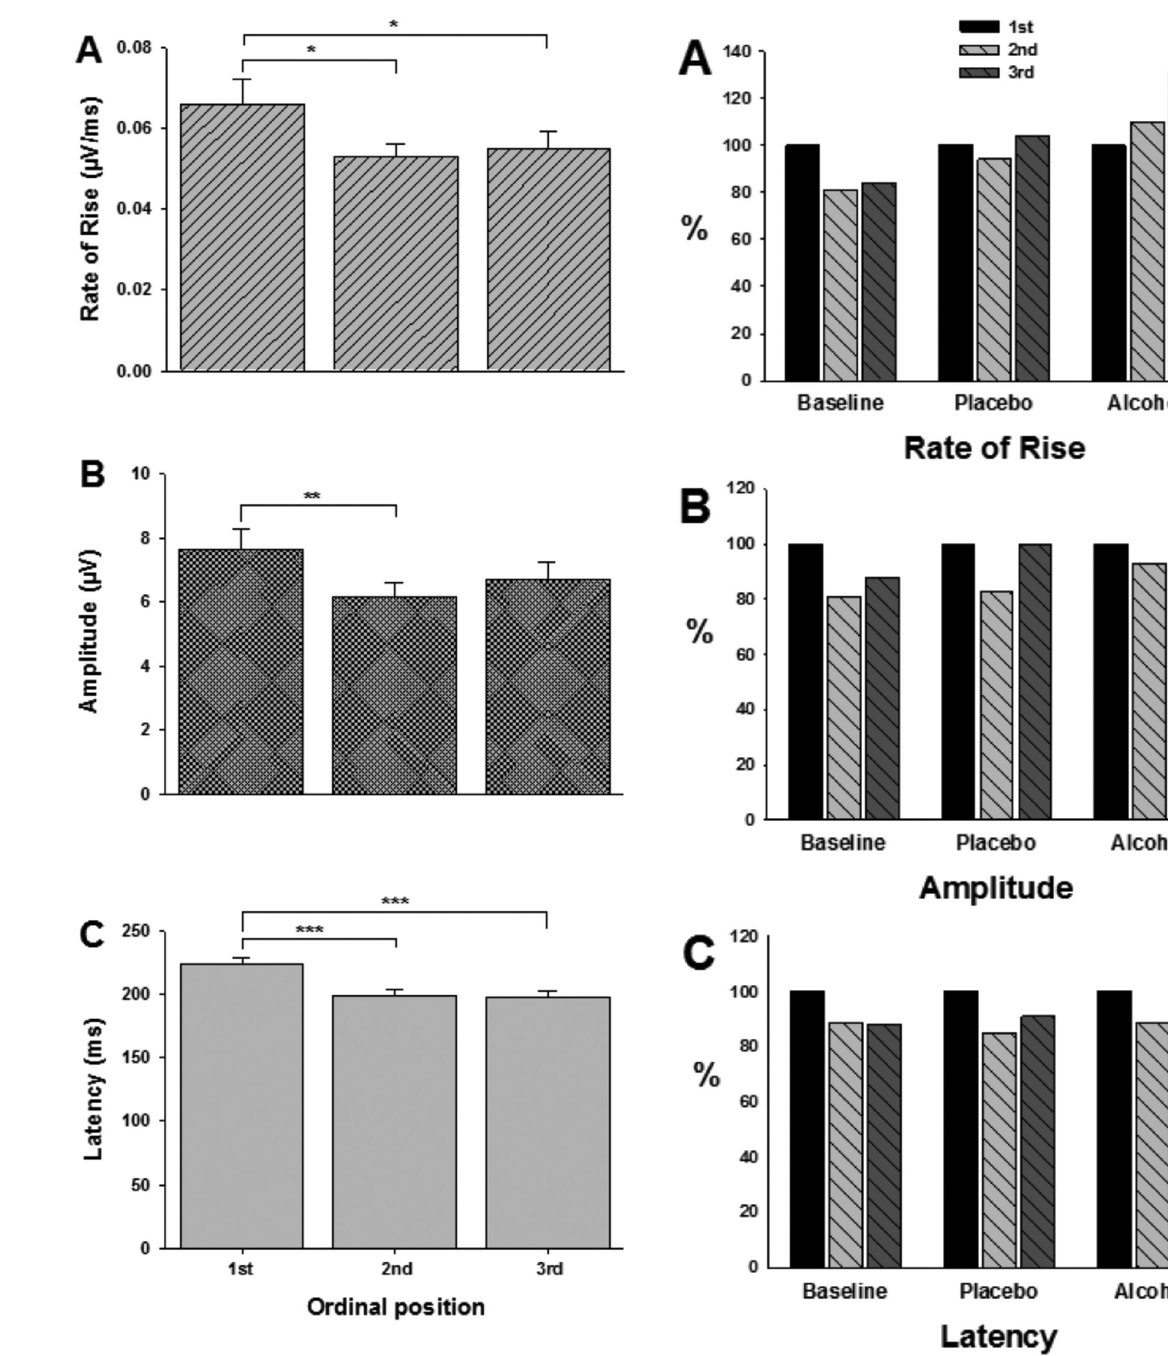
Figure 2 - P2 parameters according to the ordinal position of the stimuli under drug-free conditions. A. P2 rise rate was swifter in the first than in the second or third stimuli. B. The P2 amplitude was higher for the first than for the second stimuli. C. P2 peak latency was slower in the first than in the second or third stimuli. Vertical bars show standard errors of the mean. * P < .02; ** P < .004; *** P < .0001.